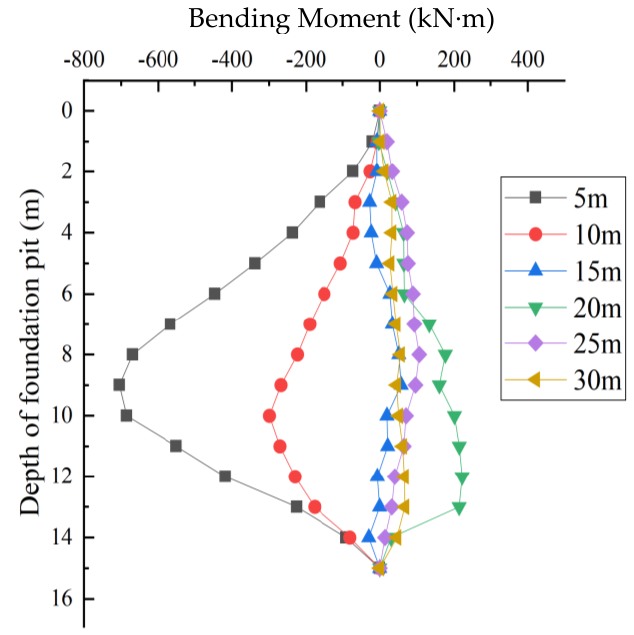
Figure 12. Pile bending moments.